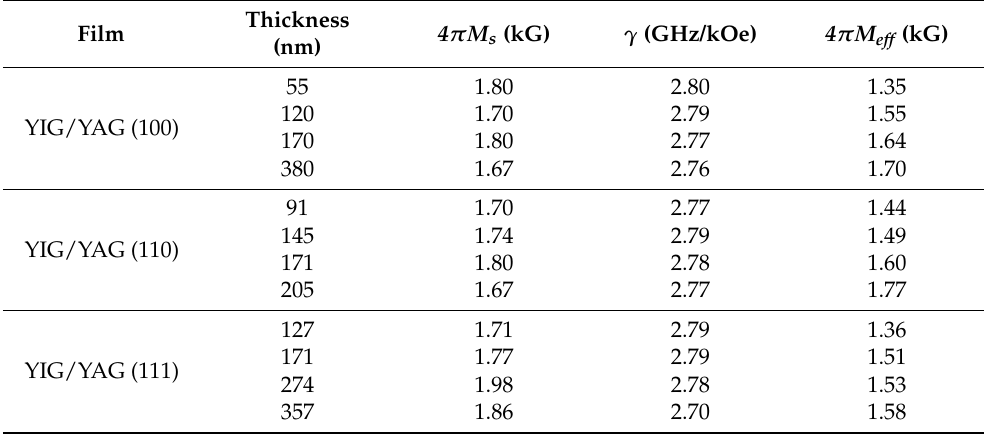
Figure 5. Normalized in plane ( a ) and out-of-plane ( b ) M-H hysteresis loops for the thickest YIG films grown on (100), (110), and (111) YAG substrates. Table 2. The saturation induction 4 π M s , gyromagtic ratio, and the effective saturation induction 4 π M eff for YIG films on YAG